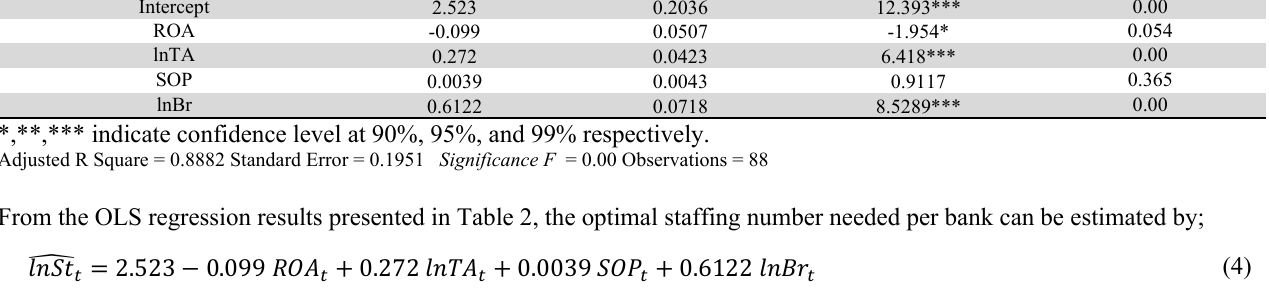
OLS Panel Regression Output Coefficients Standard Error t